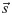
Comparison between the temporal dynamics of species’ population densities (each color represents a different species) in the consumer-resource models with fixed metabolic strategies, when the resource supply rate vector s→ varies with time.Here, we simulated a system with m = 20 species, p = 3 resources, and with the nutrient supply rate vector switching at regular intervals between the two values shown (black star and diamond) in (A). Specifically, in (B) we made s→(t) alternate periodically between s→in for τin = 12 h and s→out for τout = 48 h, with s→in chosen within the convex hull of the initial rescaled metabolic strategies and s→out chosen outside of it (see Figure G in S1 Text for more information on the parameters used). Panel (C) shows the same quantities, with τin = τout = 48 h. See Figure G in S1 Text for the dynamics of the species’ populations in the consumer-resource model with adaptive metabolic strategies.